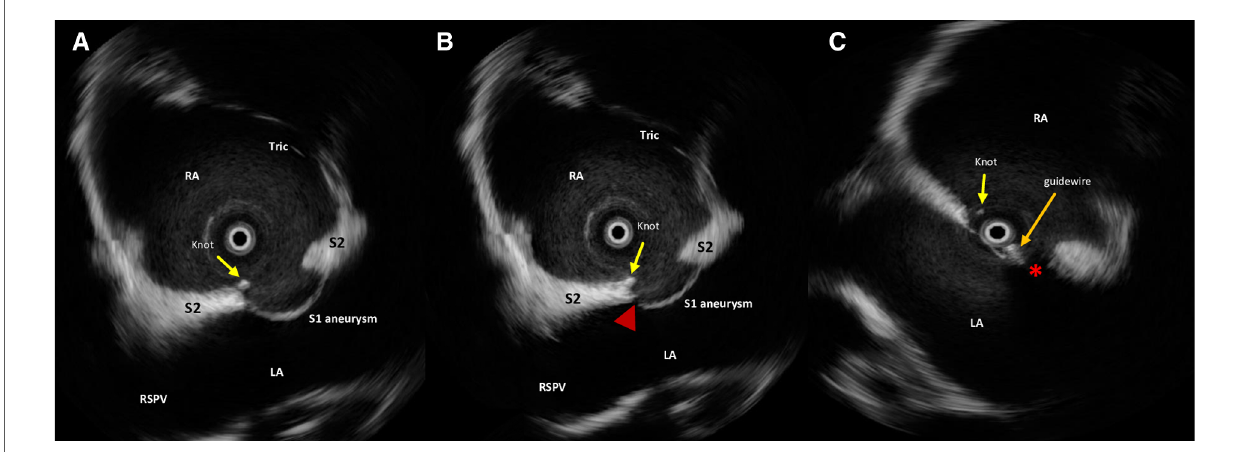
FIGURE 1 Intraprocedural rotational intracardiac Echo by Ultra ICE (mechanical 9F/9 MHz 360° scan probe, Ultra ICE TM , EP technologies, BSC, CA, United States) in the parasagittal long axis ( “ four chamber ” ) plane showing septum primum aneurysm, NobleStitch EL sealing system (radiopaque polypropylene knot, yellow arrow), laceration of the septum primum next to the knot (red arrowhead) ( A,B ) and the guidewire (orange arrow) crossing the septal fenestration (red asterisk) ( C ). S1, septum primum; S2, septum secundum; RA, right atrium; LA, left atrium; RSVP, right superior pulmonary vein; Tr, tricuspid